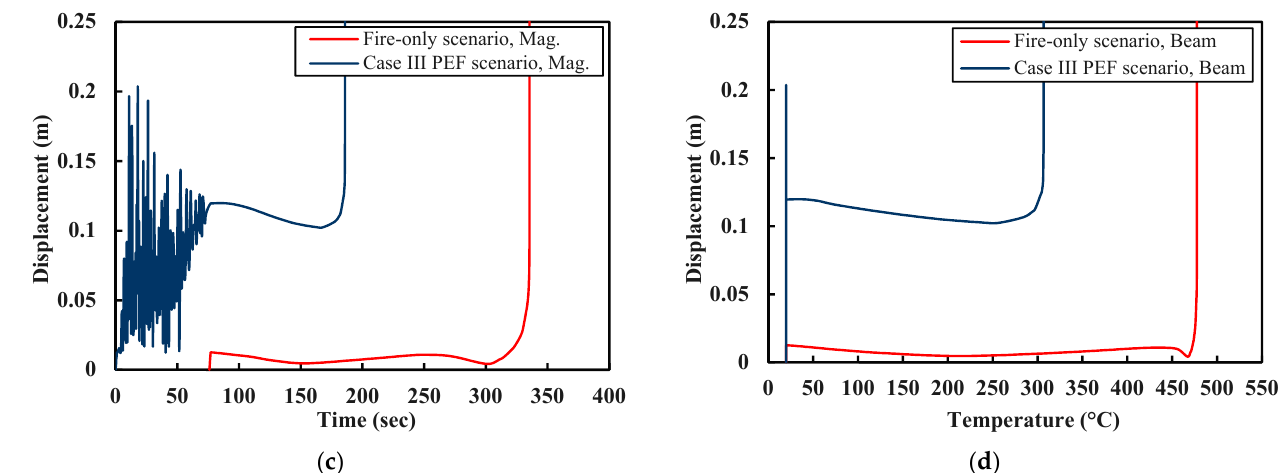
Figure 15. Comparison of the fire-only analysis versus the PEF analysis for Case III including ( a ) the time-mid-span displacement record in the z-direction, ( b ) the time-mid-span displacement record in the x-direction, ( c ) the time-mid-span displacement record for the total displacement and ( d ) the temperature-mid-span displacement record for the total displacement.